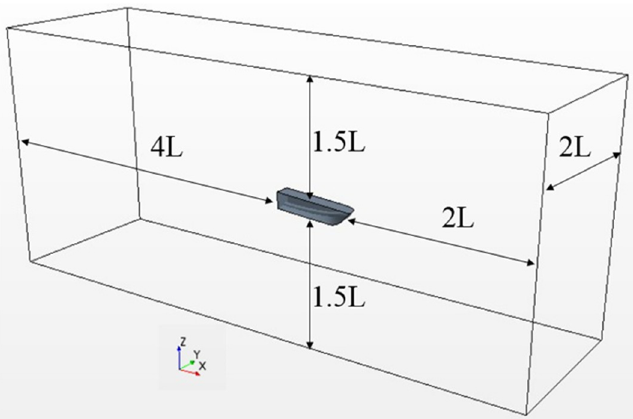
Figure 5. Dimensions of the computation domain (where L is length overall of the planing trimaran).